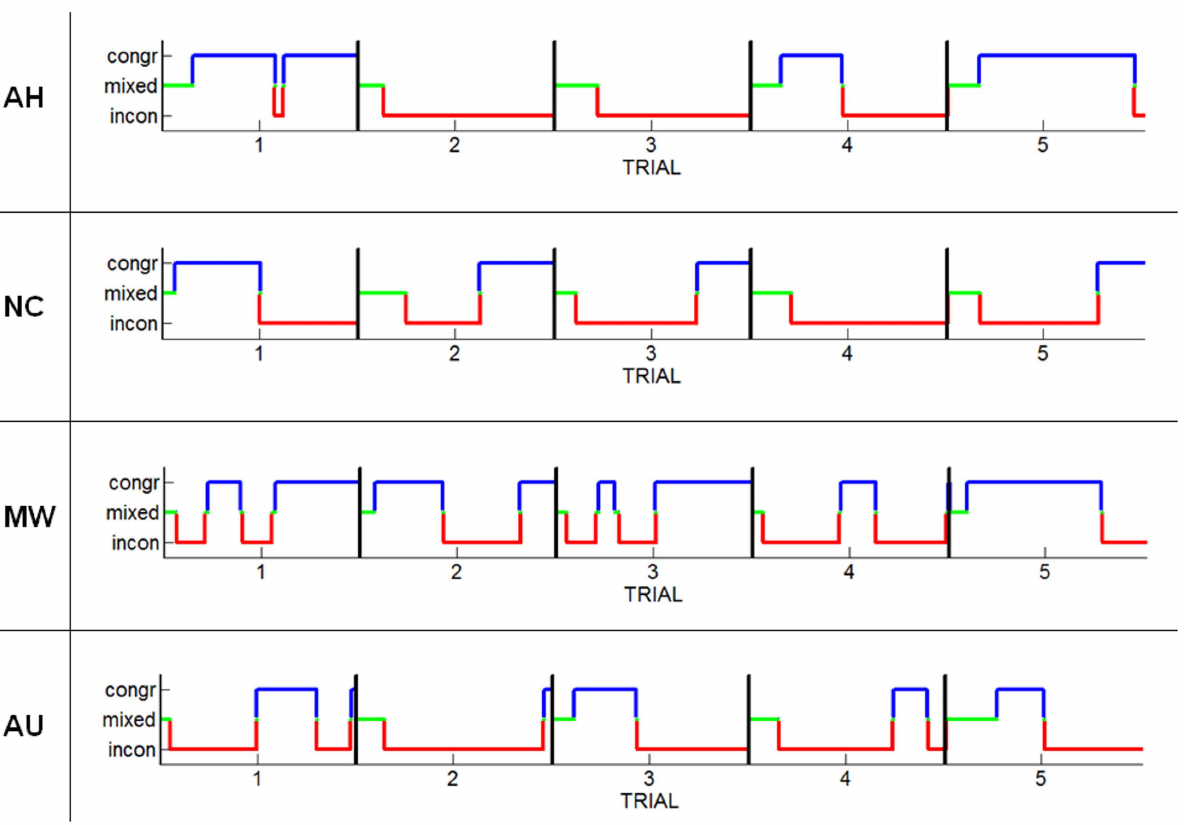
Figure 2. Example of responses from four representative observers during the first 5 trials of the WM condition. Each horizontal blue segment represents an episode of perceived congruence between the direction of motion of the ambiguous and the unambiguous sphere, each horizontal red segment represents an episode of perceived incongruence. Green segments represent mixed dominance. Black vertical lines denote the end of a trial.